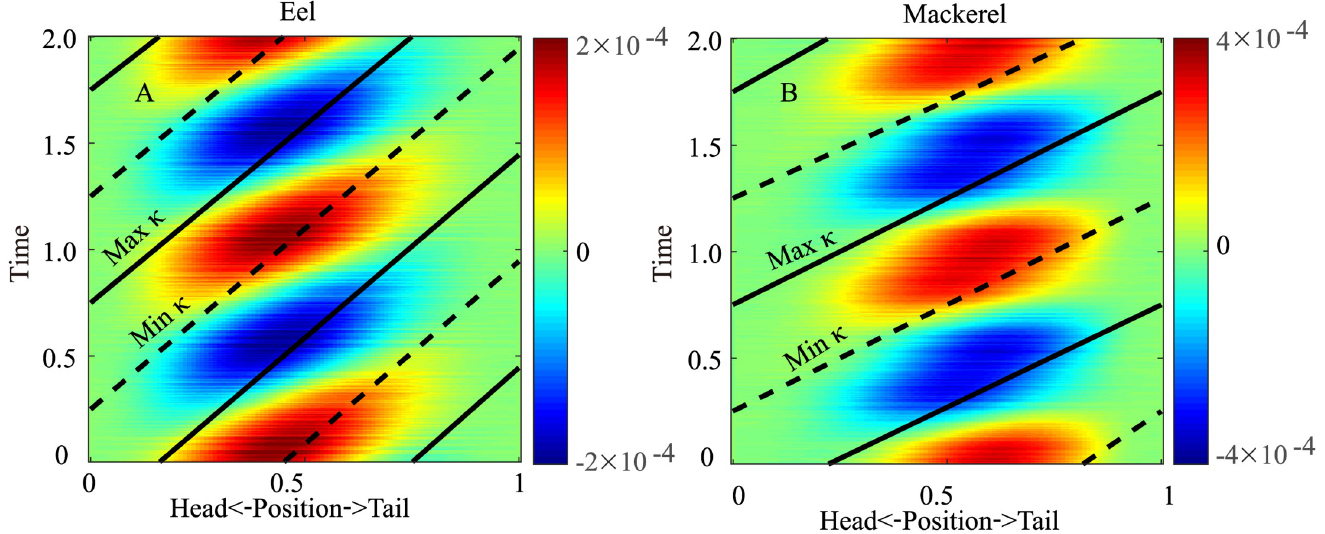
Fig 4. Spatiotemporal distribution of the torque on the body in two periods for the eel (A) and the mackerel (B). The solid and dashed lines indicate the maximum and minimum curvatures, respectively. The same information is illustrated in S3 and S4 Videos.